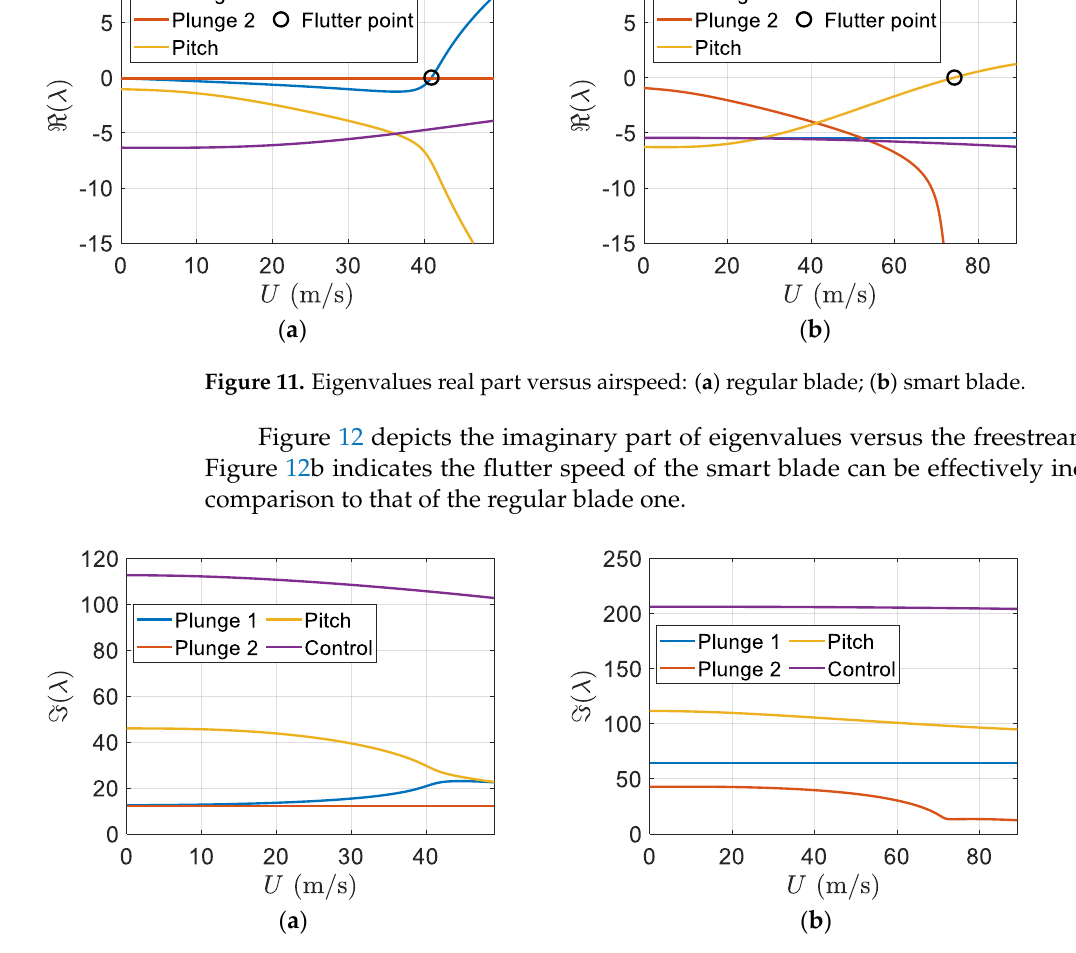
Figure 12. Eigenvalues imaginary part versus airspeed: ( a ) regular blade; ( b ) smart blade. Equation (8) can be used to form the matrix 𝑸, and its eigenvalues and eigenvectors can be obtained for two different airspeeds, 𝑈 = 10 m s⁄ , and the flutter speed, 𝑈 = 74.2973 m s⁄ . The structural states dynamics of the smart blade can be represented in eight complex eigenvalues. The complex eigenvalues of the regular blade are conjugate as the complex eigenvalues of the smart blade. Six real eigenvalues belong to